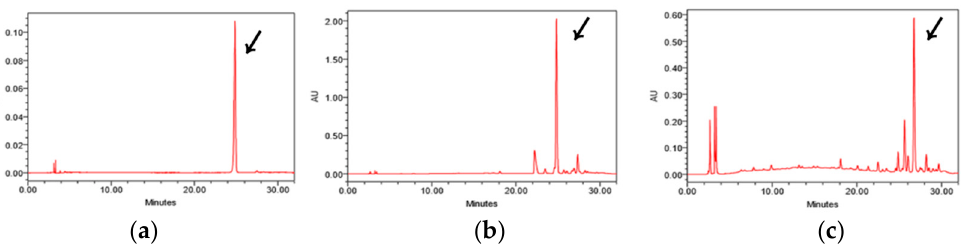
Figure 9. HPLC chromatogram of ( a ) myricitrin and hot-water extracts of the leaf ( b ) and branch ( c ) of S. samarangense .